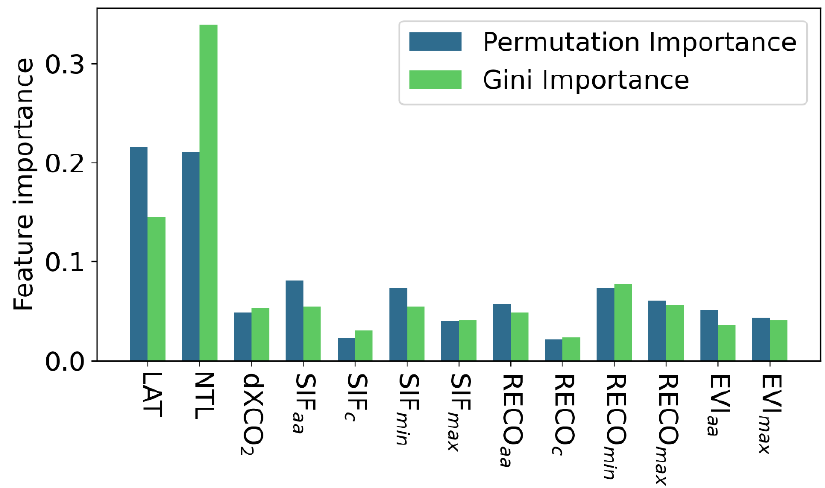
Figure 6. Normalized feature importance of different inputs in the two-layer stacked